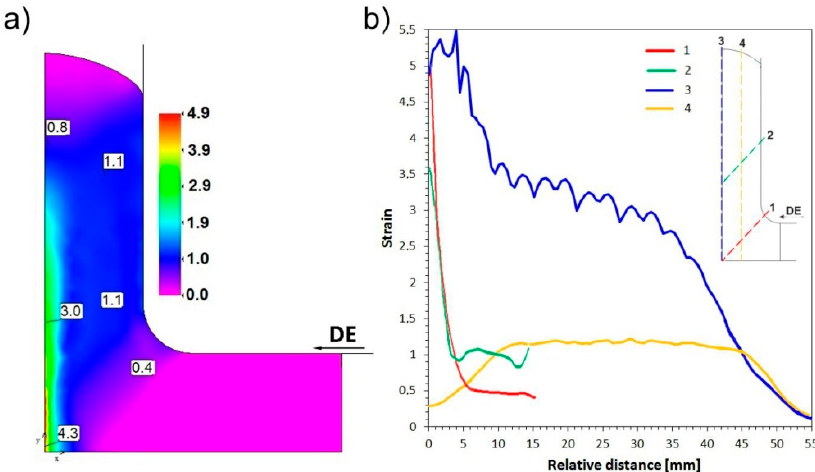
Figure 4. Equivalent plastic strain ( ε ): ( a ) Maps of distribution and ( b ) graph of its values at 1st pass, BP = 0 MPa.